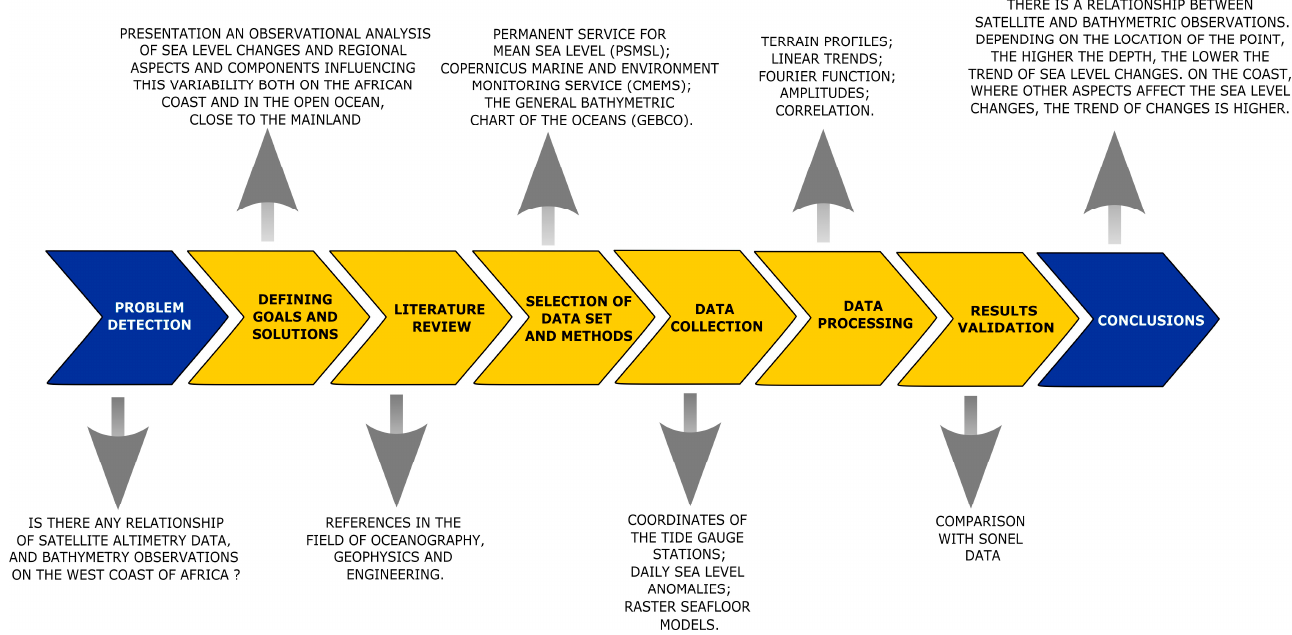
Figure 2. Flow chart of the study process.